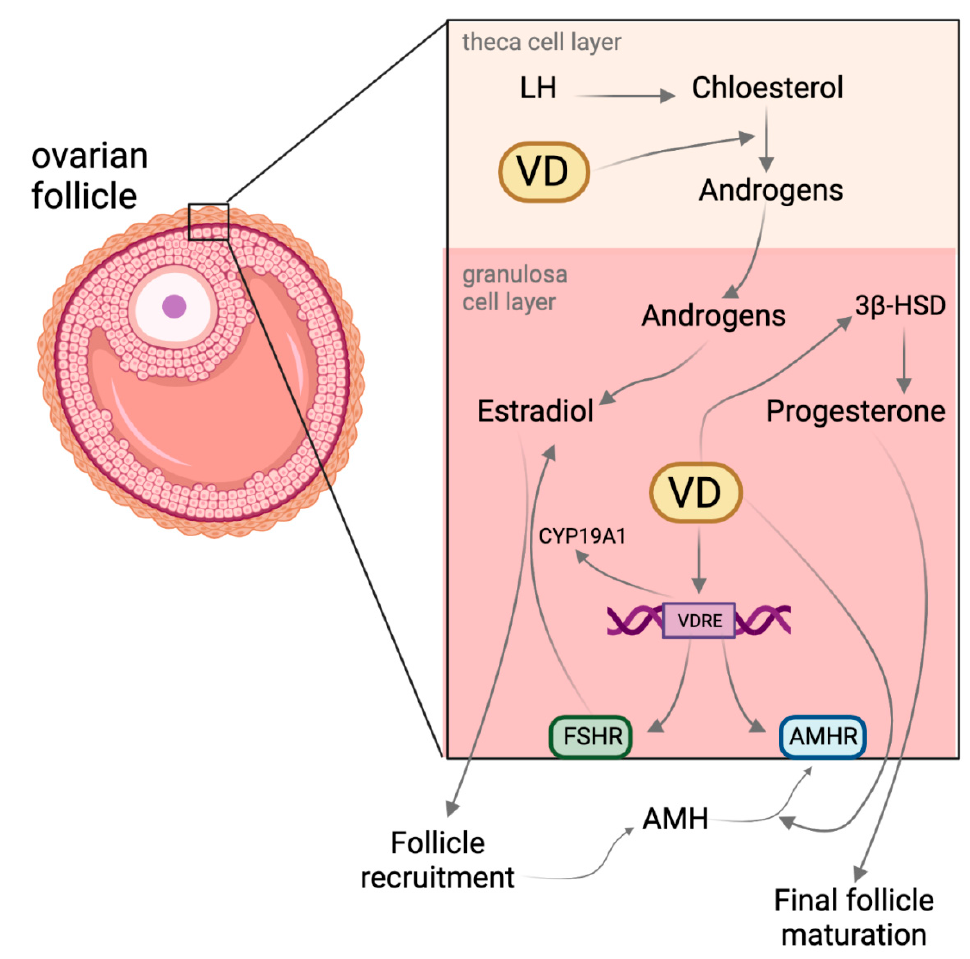
Figure 1. Molecular overview of vitamin D (VD) action in theca cell and granulosa cell layer. VD regulates hormone production and receptor expression in theca and granulosa cells of developing follicles. This, in turn, affects follicle recruitment and maturation. VD also affects 3- β -hydroxysteroid dehydrogenase (3 β HSD) and the anti-Müllerian hormone (AMH). Abbreviations: AMHR, anti-Müllerian hormone receptor; FSHR, follicle-stimulating hormone receptor; VDRE, vitamin D response elements.